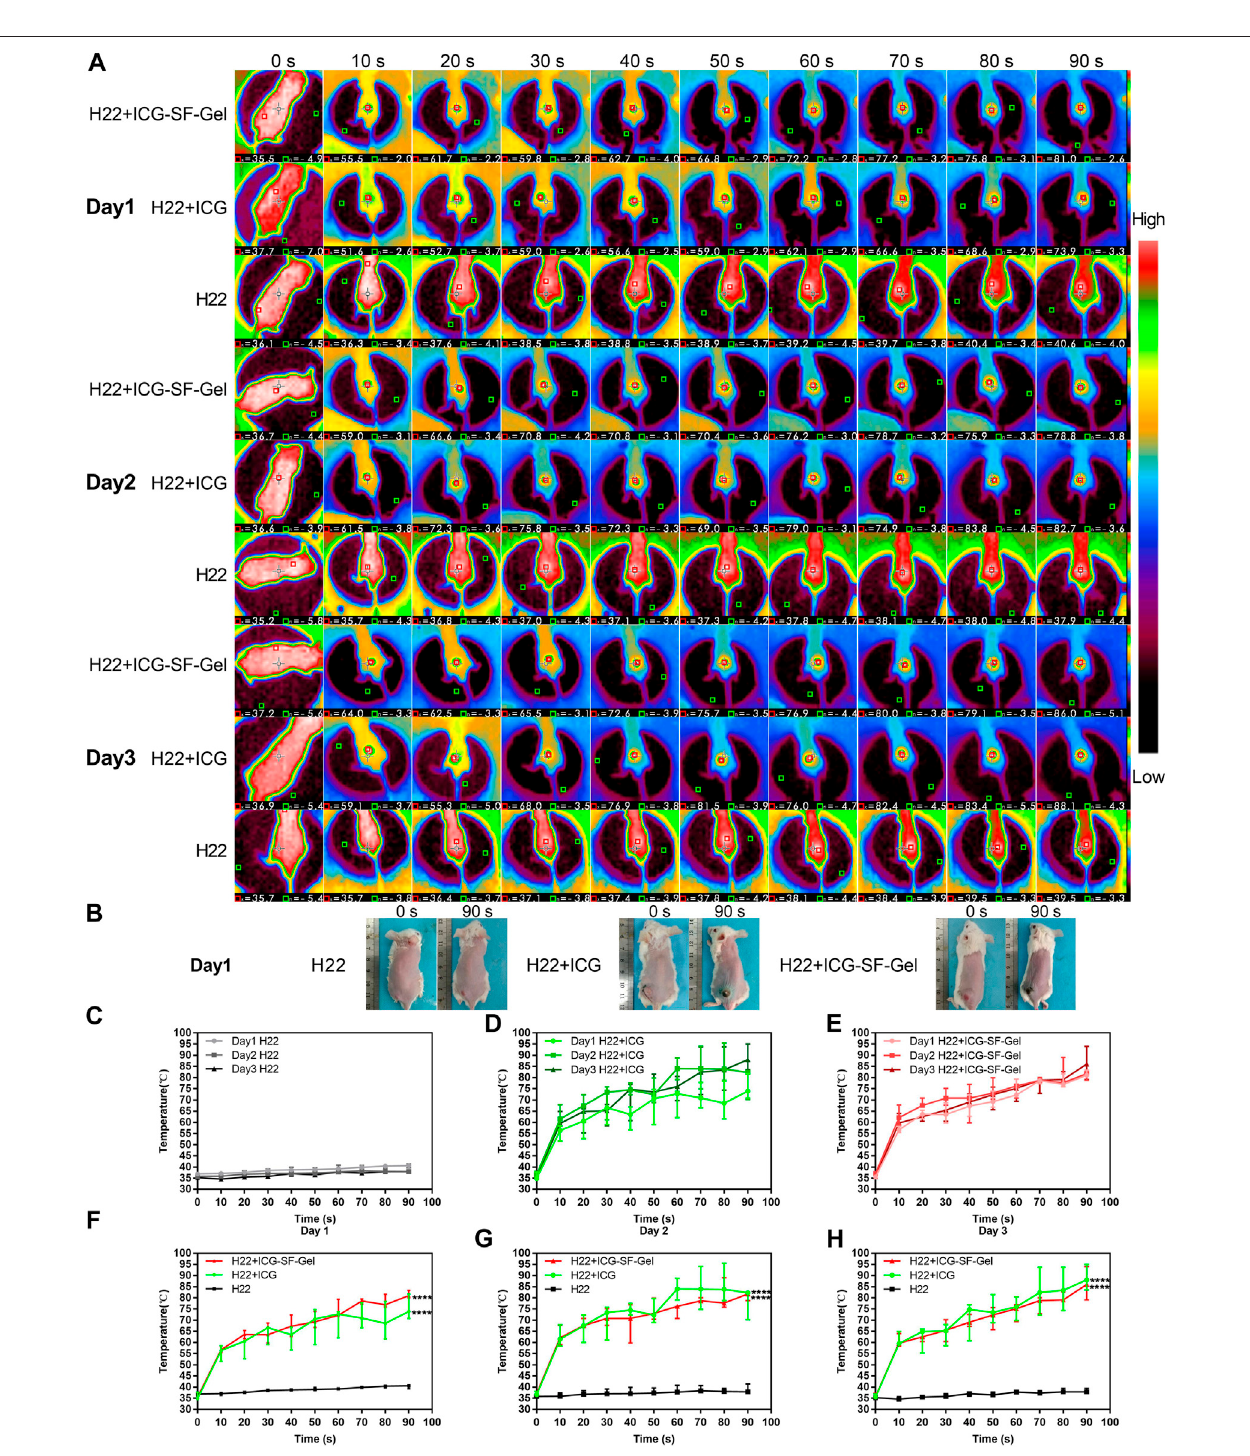
FIGURE 3 | The photothermal effect of ICG and ICG-SF-Gel in vivo . (A) The thermo-graphic images of H22 + ICG-SF-Gel, H22 + ICG, and H22 groups mice after NIR irradiation atevery10 sintervalsfor90 sduringthe3 days NIR irradiation; (B) Thedigital photograph ofH22+ICG-SF-Gel, H22+ICG andH22groupsmicebefore andafterNIRirradiationonDay1; (C – E) ThetemperaturechangesoftumorareainH22 (C) ,H22+ICG (D) andH22+ICG-SF-Gel (E) groupsmiceafterNIRirradiationat every10 sintervalsfor90 sduringthe3 daysNIRirradiation; (F – H) ThetemperaturechangesoftumorareainH22,H22+ICGandH22+ICG-SF-Gelgroupsmice after NIR irradiation at every 10 s intervals for 90 s on Day 1 (F) , Day 2 (G) and Day 3 (H) ( n (cid:2) 3 mice per group, data are presented as the mean ± SD. Statistical signi fi cance was expressed by * p < 0.05, ** p < 0.01, *** p < 0.001 and **** p < 0.0001, comparing other groups with the H22 group).